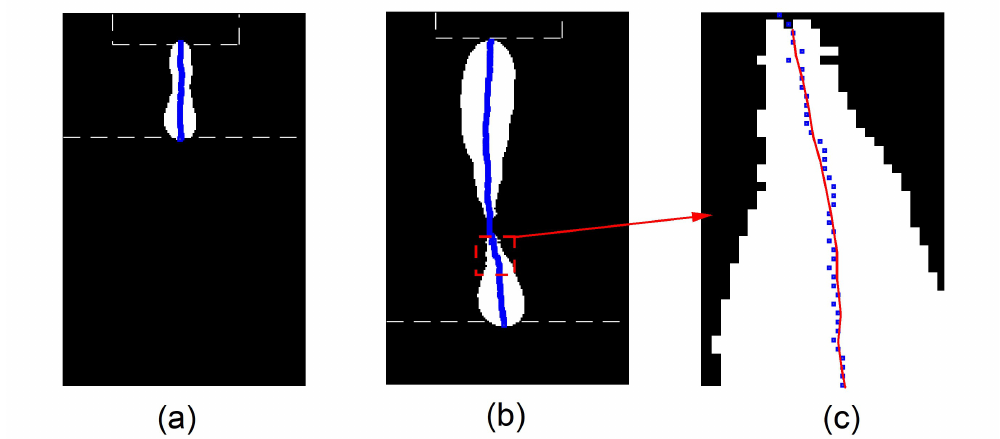
Figure 7. Arc length calculation ( a ) at 2 mm and ( b ) at 5 mm; ( c ) magnification of image. Blue dots represent midpoints and red line the calculated